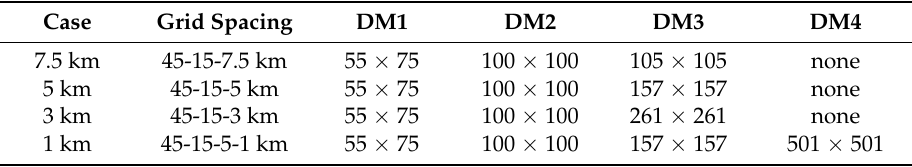
Table 1. Domain settings for the four suites of simulations with different horizontal